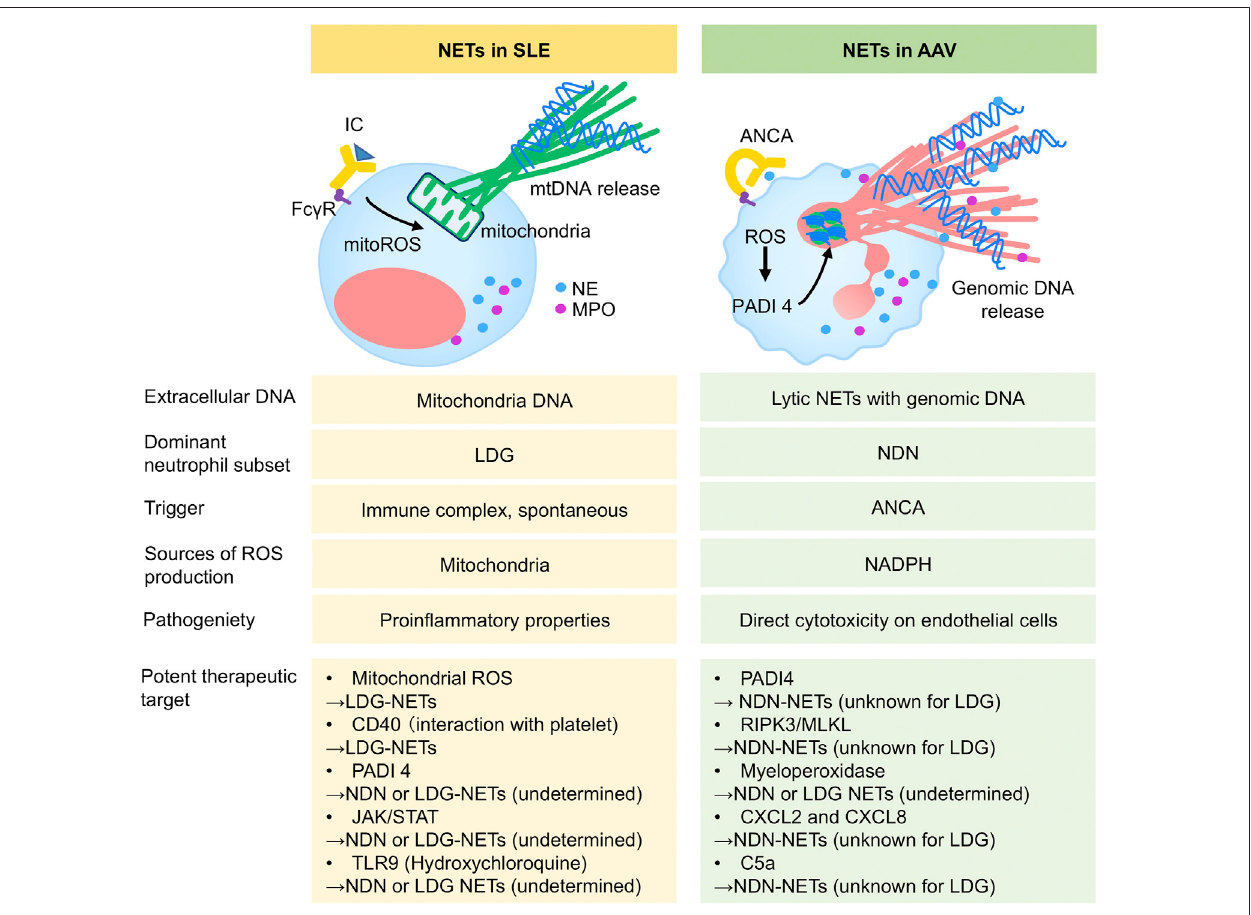
FIGURE1| ThecharacteristicsofSLE-NETsandAAV-NETs.SLE,Systemiclupuserythematosus;AAV,ANCA,anti-neutrophilcytoplasmicantibody;AAV,ANCA- associated vasculitis; IC, immune complex; ROS, reactive oxygen species; mtROS, mitochondrial ROS; mtDNA, mitochondrial DNA, LDG, low density granulocyte; NDN, normal density neutrophil; NE, neutrophil elastase; MPO, myeloperoxidase; PADI, PeptidylarginineDeiminase; RIPK, receptor-interacting serine/threonine protein kinase; MLKL, mixed lineage kinase domain-like; JAK/STAT, Janus kinase-signal transducer and activator of transcription; TLR, toll like receptor.